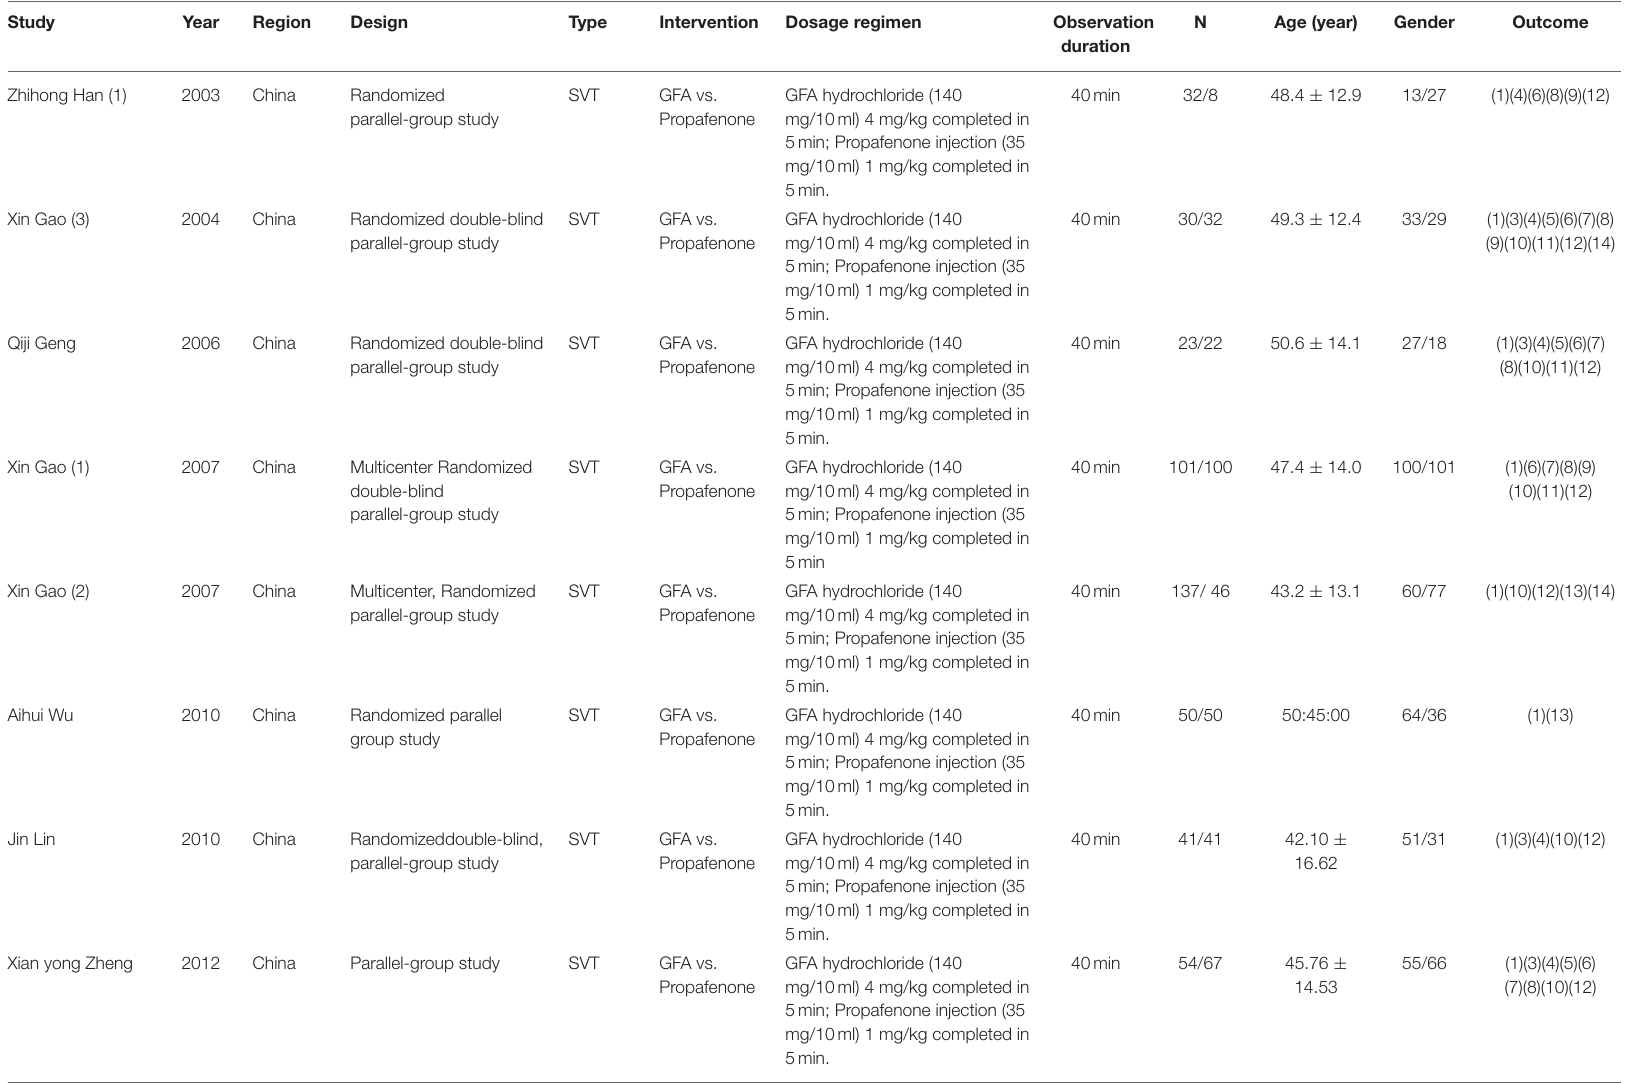
TABLE 1 | Characteristics of included studies.